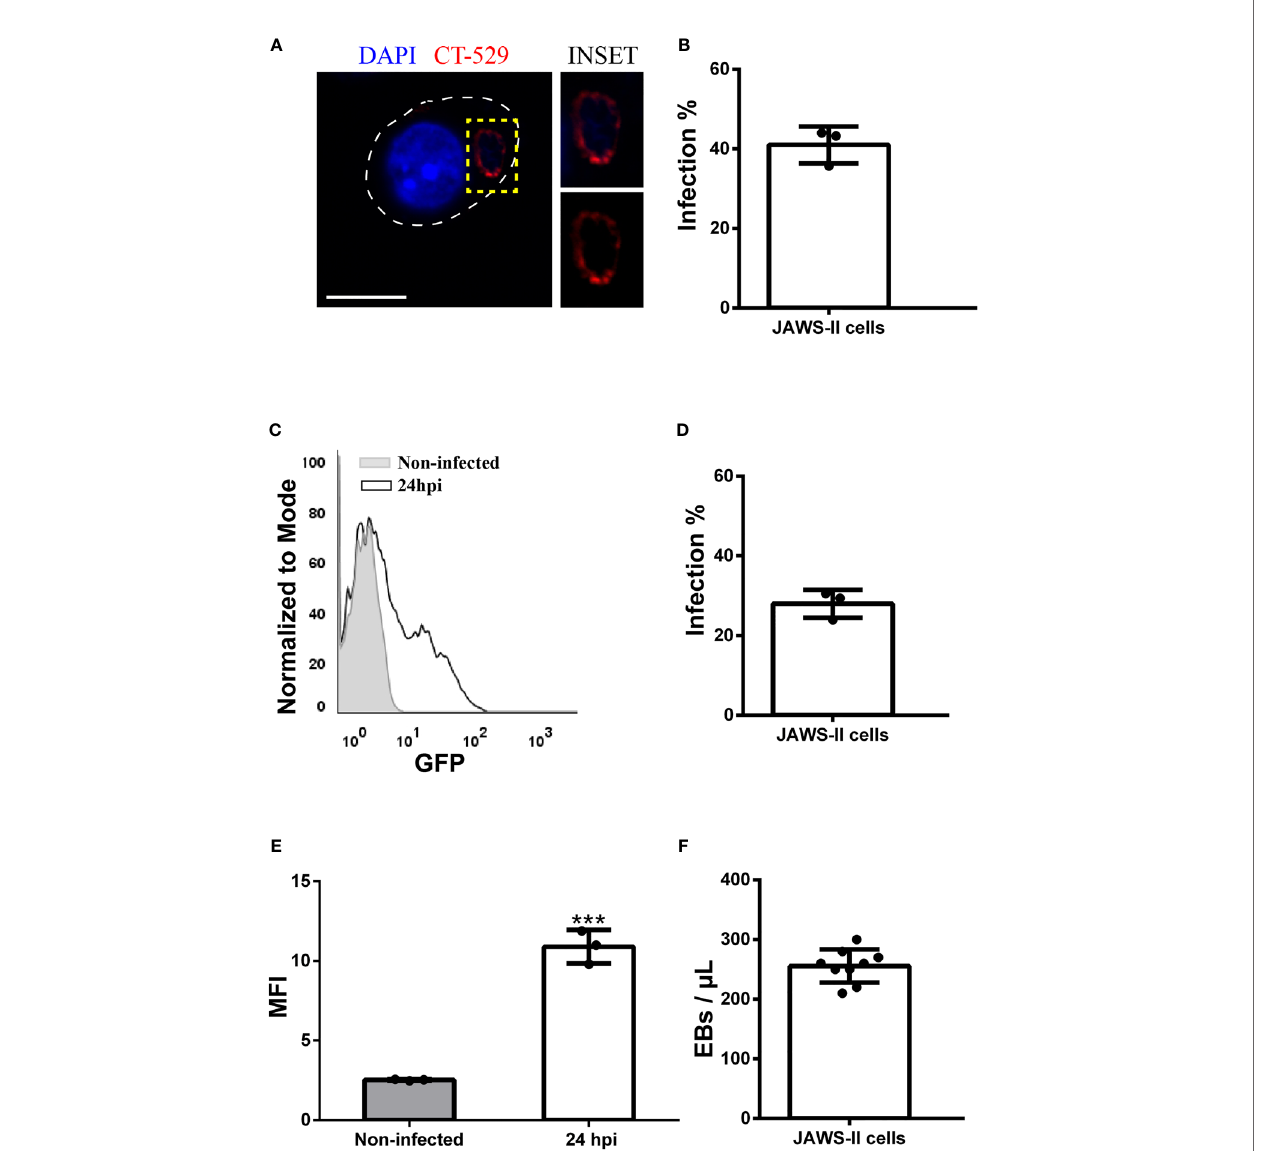
FIGURE 1 | Chlamydia trachomatis infects murine JAWS-II DCs. (A – E) JAWS-II DCs were infected with Chlamydia trachomatis serovar L2 (MOI 100) for 24 and analyzed by (A, B) confocal microscopy and (C – E) fl ow cytometry. (A) DNA was labeled with DAPI (blue) and the membrane chlamydial inclusion protein CT-529 (red) was detected with a rabbit anti-CT529 antibody and a secondary anti-rabbit Cy3-labeled antibody. Bars represent 10 um. (B) Data represent the mean ± SEM (41,00 ± 2,658) of three independent experiments. (C) Representative FACS histograms showing the fl uorescence intensity of non-infected (grey) and infected (black) JAWS-II DCs. (D) Data represent the mean ± SEM (27,97 ± 2,009) of three independent experiments. (E) Data show the MFI of GFP and represent the mean ± SEM of three independent experiments. P-value = 0.0002. The two-tailed Student ’ s unpaired t-test was performed. (F) JAWS-II DCs were infected with C . trachomatis L2 (MOI 100) for 72 h, lysed, and titrated on a monolayer of HeLa cells. Then, the number of EBs produced by infected DCs was calculated. Data represent the mean ± SEM (42,59 ± 1,554) of three independent experiments. ***P <